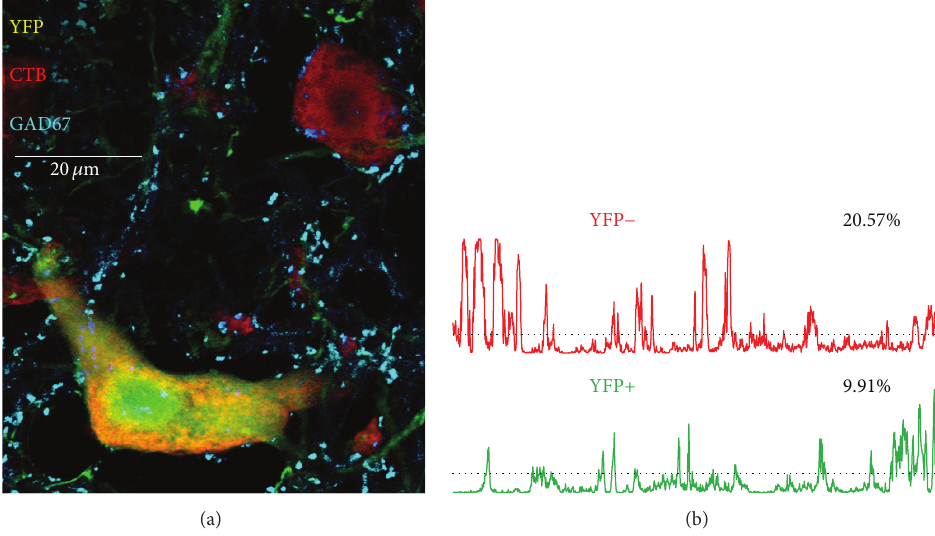
Figure 2: (a) Two motoneurons in a single optical section in lamina IX of the ventral horn of the lumbar spinal cord of a tamoxifen treated SLICK::trkB f / f mouse are shown. Both neurons are marked by the presence of a red fluorescent retrograde tracer, cholera toxin B-Alexa Fluor 546,thathadbeeninjectedintothegastrocnemiusmusclesthreedayspriortotissueharvesting,identifyingthesecellsasmotoneurons.Oneof the cells also expresses yellow fluorescent protein (YFP) and was assumed to be null for the gene for trkB. Cyan structures are immunoreactive for glutamic acid decarboxylase 67 (GAD67). (b) Profile plots are shown for GAD67 immunoreactivity along the perimeters of these cells. In each plot, the average fluorescence intensity + one standard deviation is shown as a threshold by the horizontal dashed line. Fluorescence intensity values greater than this threshold are assumed to represent contacts between the perimeter of the cell and structures immunoreactive for GAD67. The numbers next to each plot indicate the percent of the perimeter of the cell in such